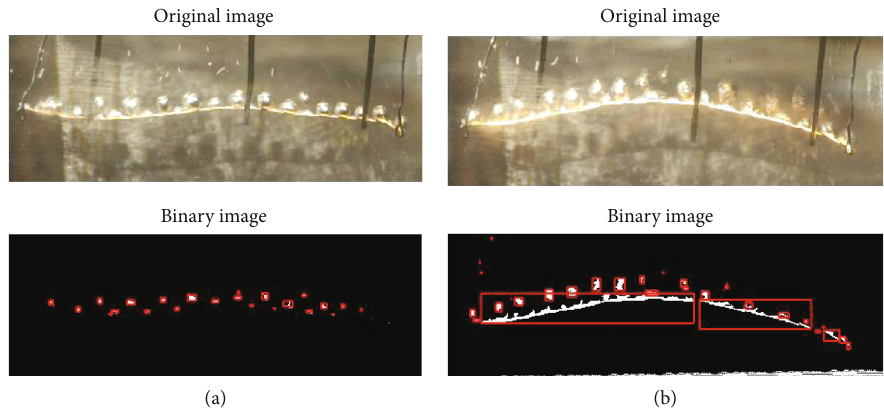
Figure 17: Nucleation sites on heater surface: (a) water and (b) water at higher PHF.